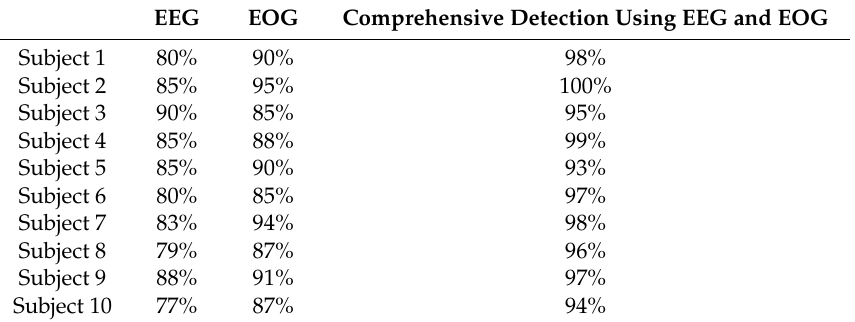
Table 1. Accuracy comparison of motion direction recognition.